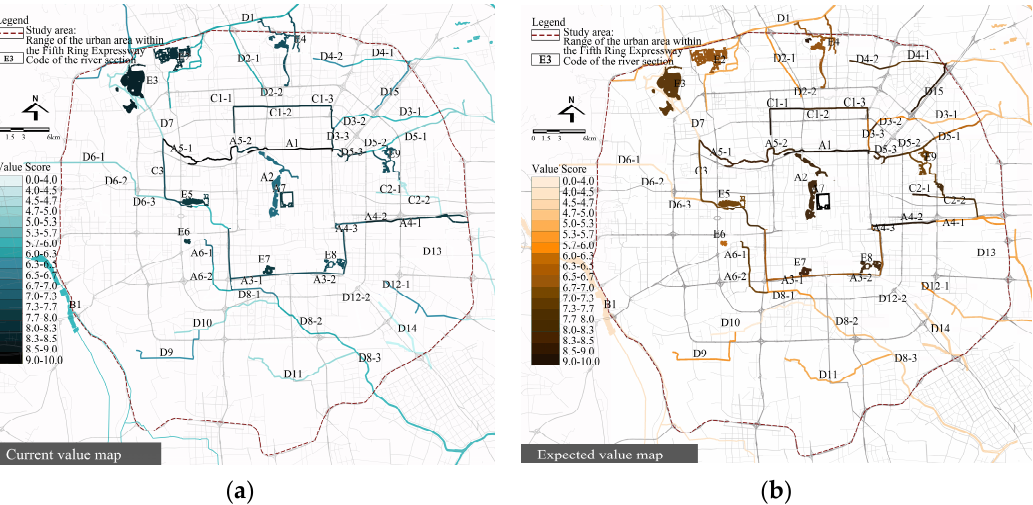
Figure 5. The current and excepted value map of Beijing’s waterfront : ( a ) the current value map and ( b ) the expected value map.